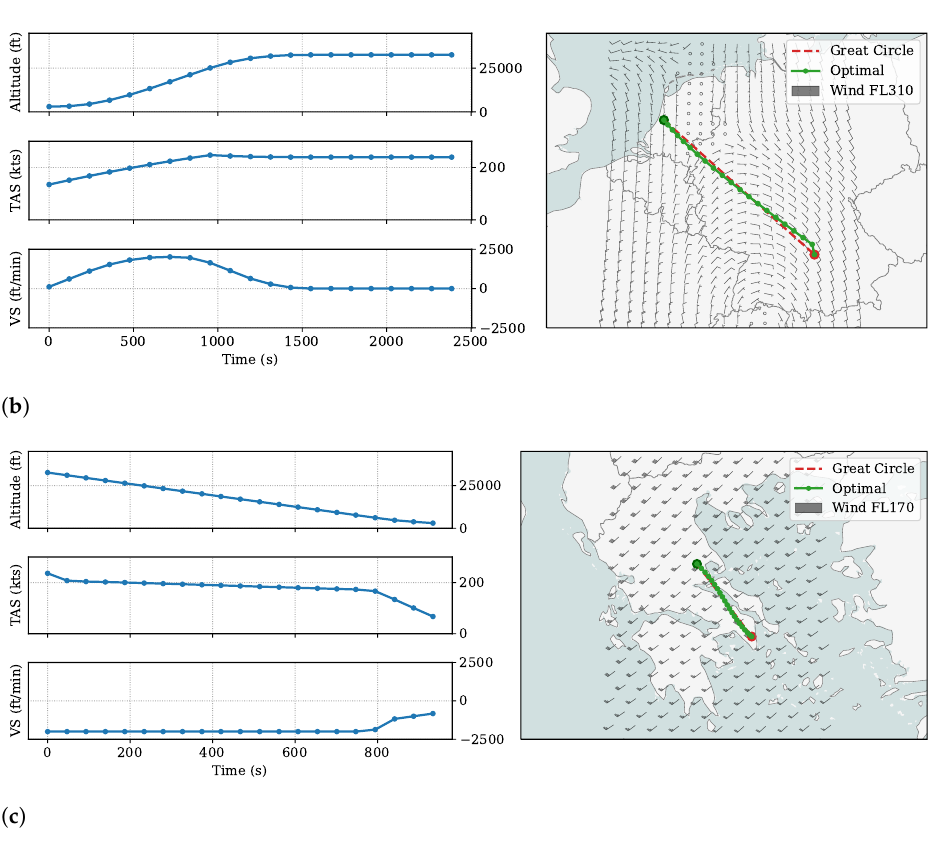
Figure 5. Optimization of different flight phases for minimizing fuel consumption. The example flight leaves EHAM, arrives at LGAV, and considers the real 3D wind conditions. Only the wind field at a specific altitude is shown for illustration purposes. ( a ) Optimal cruise trajectory, ( b ) Optimal climb trajectory, and ( c ) Optimal descent